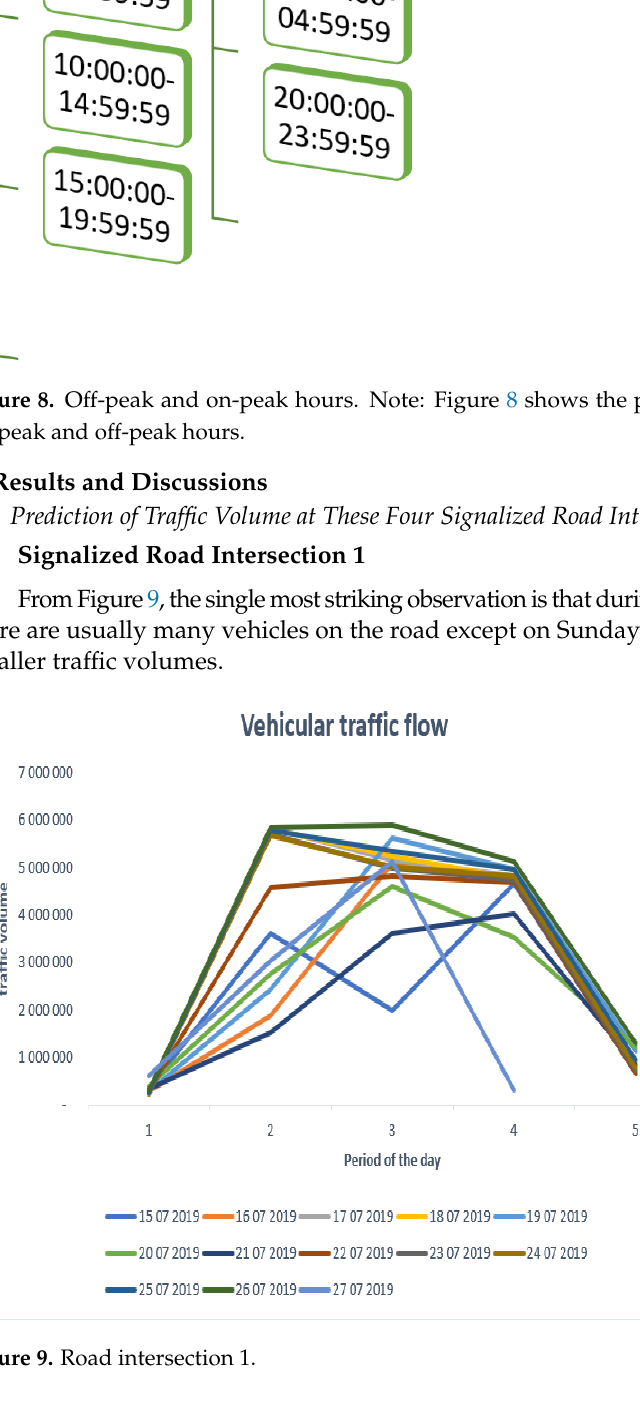
Figure 10. Road intersection 2.